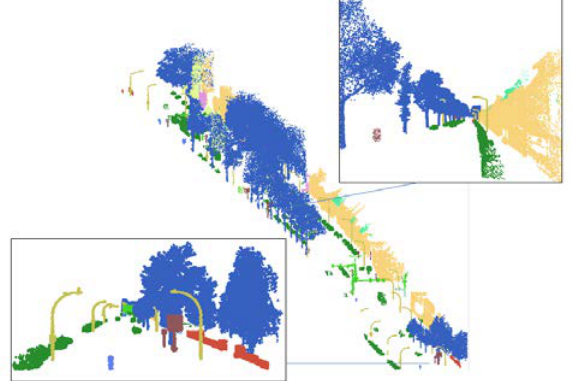
Figure 8 Test labels of 337 segments of 13 (sub) classes of a 800 m MLS